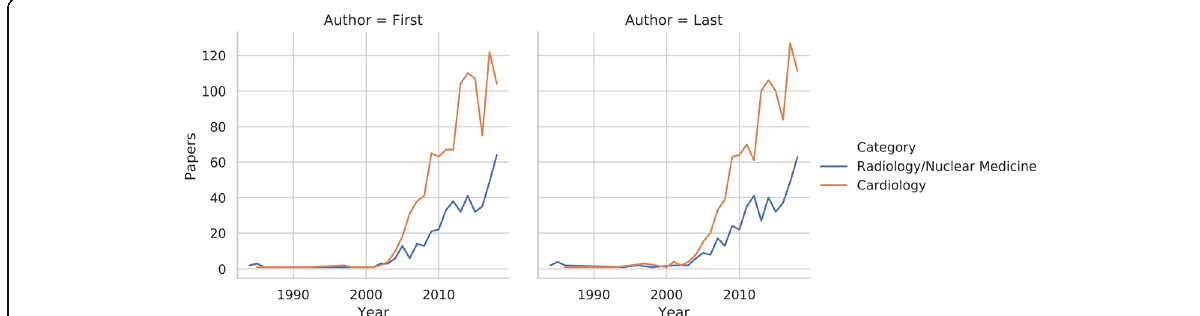
Fig. 2 Line plot depicting the number of studies published by cardiologists or radiologists/nuclear medicine physicians as the first or last authors over the years